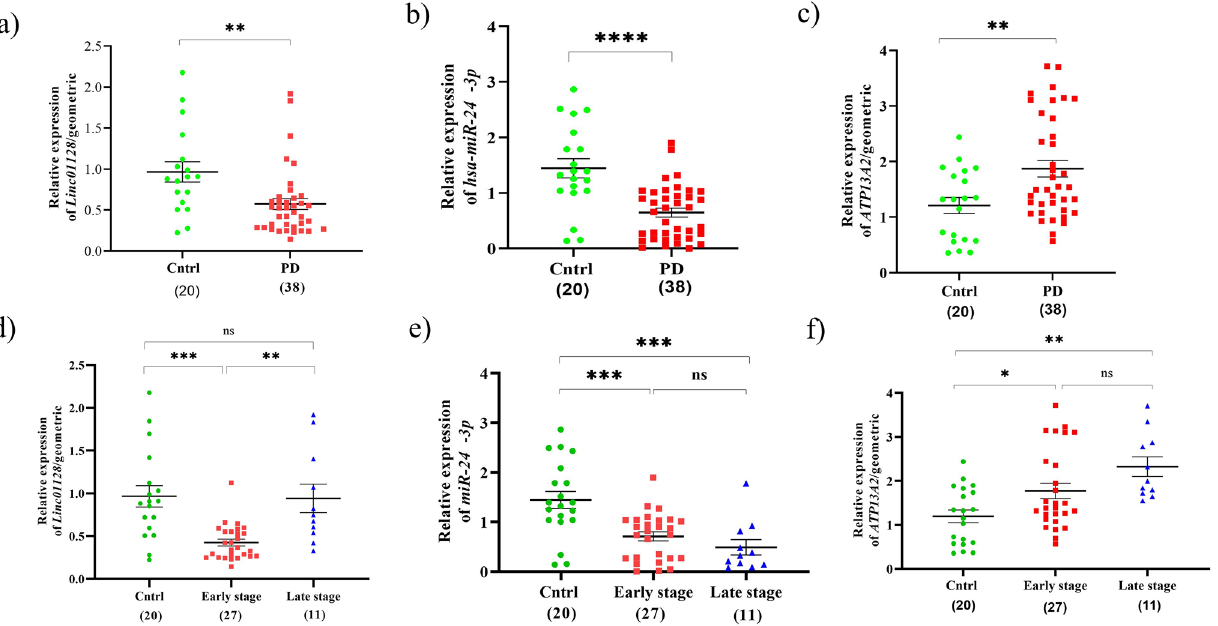
Figure 1. Evaluation of the lncRNA, miRNA and mRNA relative expression as formed in the first regulatory network. QRT-PCR analysis of RNA expression in the PBMC of: ( a – c ) control subjects and PD patients. ( d – f ) control subjects and PD early and late stage groups, based on the UPDRS score. All data are represented as mean ± SEM (***p ≤ 0.001, **p ≤ 0.01, *p ≤ 0.05, and ns p > 0.05).